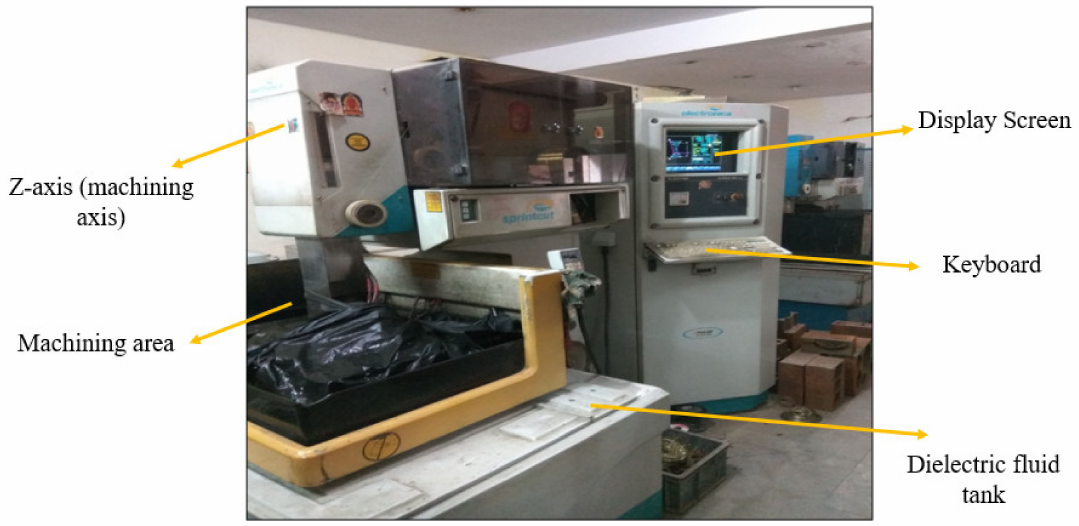
Figure 2. Pictorial view of the WEDM tool (courtesy: DIT University,